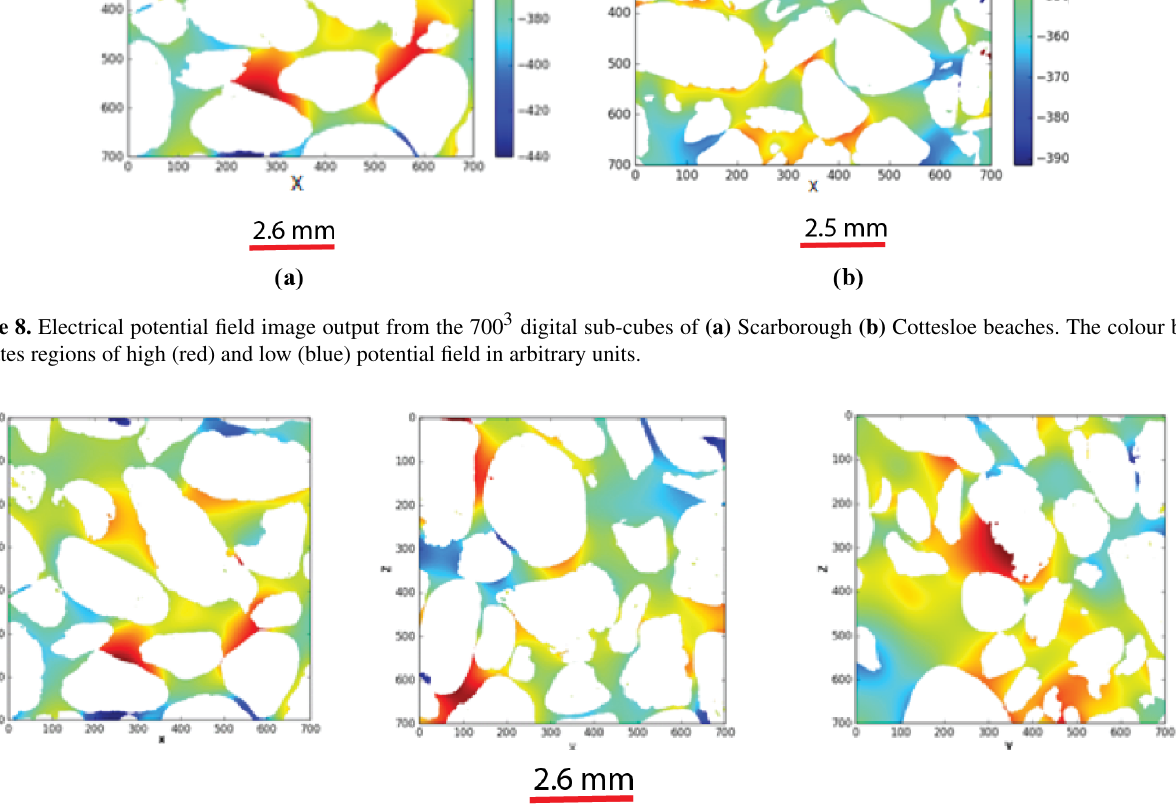
obtained by compacting the initial sand pack. Correlation co-